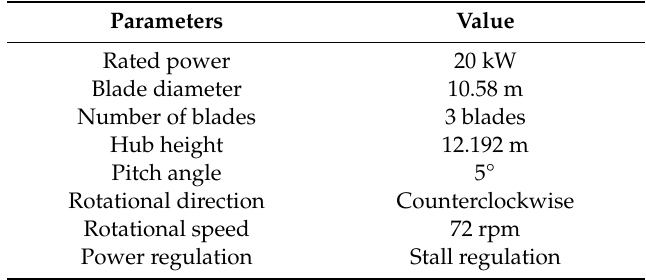
Table 1. Specification and operating parameters of the NREL CER. Parameters